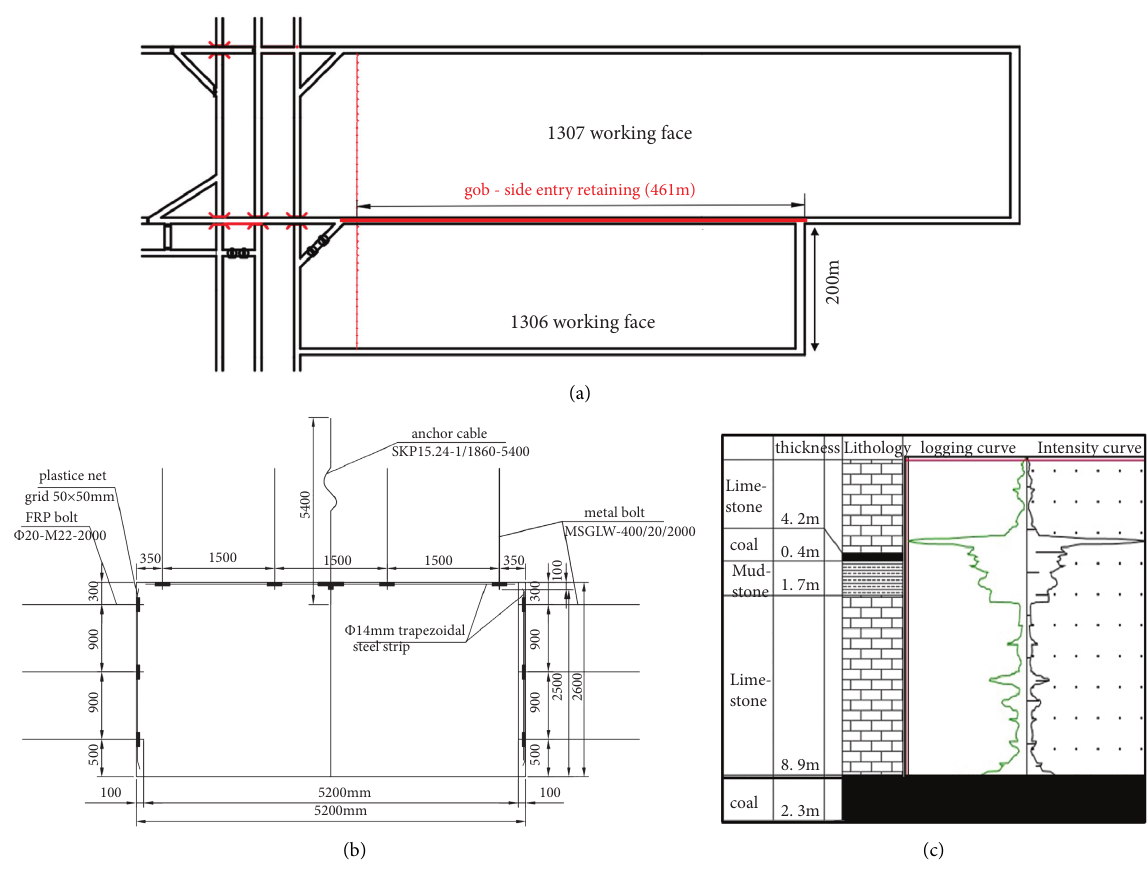
Figure 8: Related parameters of test working face. (a) The test working face is 1306 working face, and the roadway reserved for nonpillar mining is 461m. (b) The roadway, which will reserved for nonpillar mining, has a rectangular section of 5.2 m × 2.6m and adopts the support method of “anchor cable-bolt-plastic net.” (c) Integrated column chart of roof lithology of the roadway shows K2 limestone has an average thickness of 8.9m.